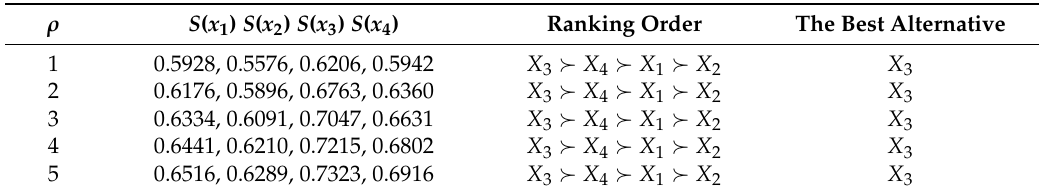
Table 1. Ranking results of the NCDWAA operator for different operational parameters.